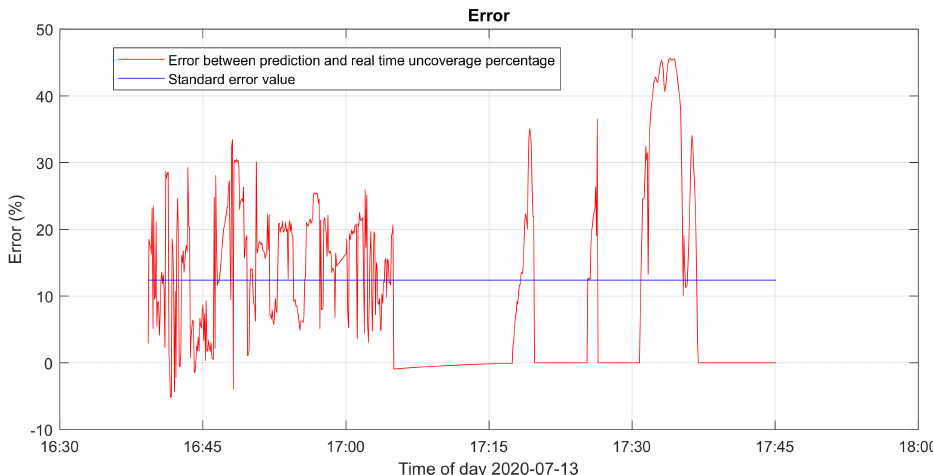
Figure 19. Error level between real-time and predicted level of sun un-coverage on 13 July 2020 from 16:30 until 17:45.